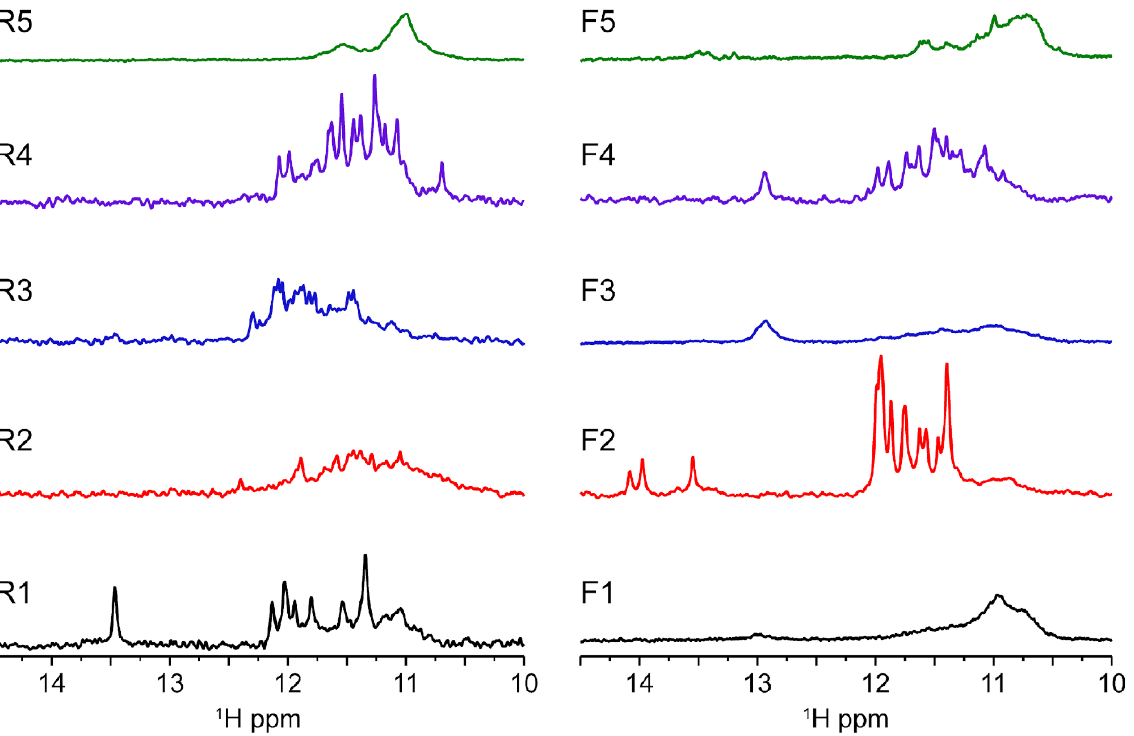
Figure 4. MST1R reverse and forward sequences imino region at 37 °C showing results in agreement with native gel experiment. R1, F2 and F4 exhibit spectra with quite well-resolved peak supporting the formation of three-tetrad G-quadruplexes. Looking to the medium-broad 1D NMR profile, some monomeric species seems to be in equilibrium between different conformers (R3 and F4), whereas the other seems to form higher molecular weight complexes. R1 seems to form a bimolecular quadruplex. All experiments were performed in buffer 1X (50 mM KCl; 10 mM KPi; pH 6.6).